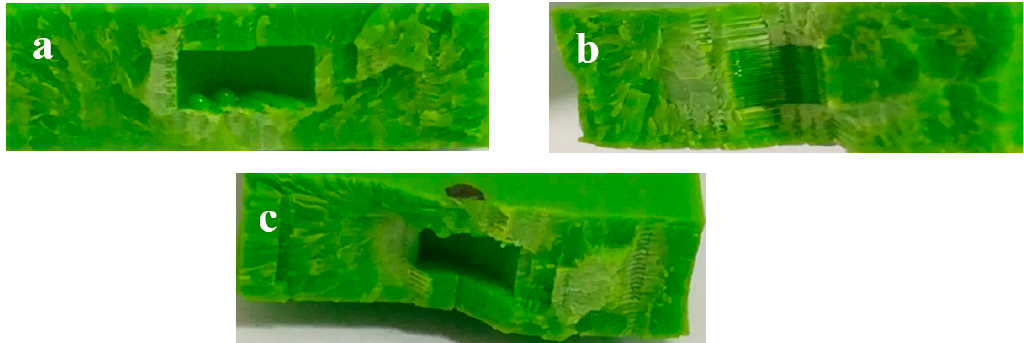
Figure 6. Optical microscopic images (10× magnification) of fracture surfaces ( a ) perpendicular to the axis 0°, ( b ) along the axis 90°, and ( c ) 45° [38]. The dimension of the defects in gray samples was half of the defect dimension in green samples. The images of gray samples, shown in Figure 7, were captured during the 3D printing process.